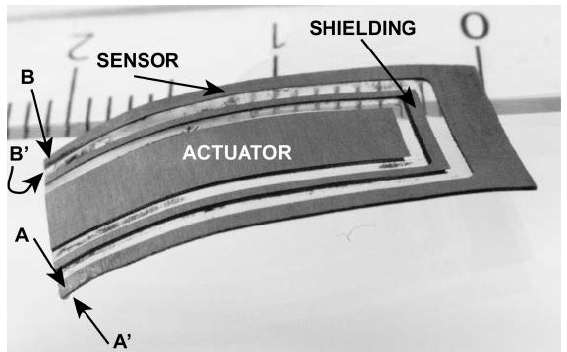
Figure 21. IPMC with patterned electrodes, reproduced from [10], Copyright (2010), with permission from SPIE.